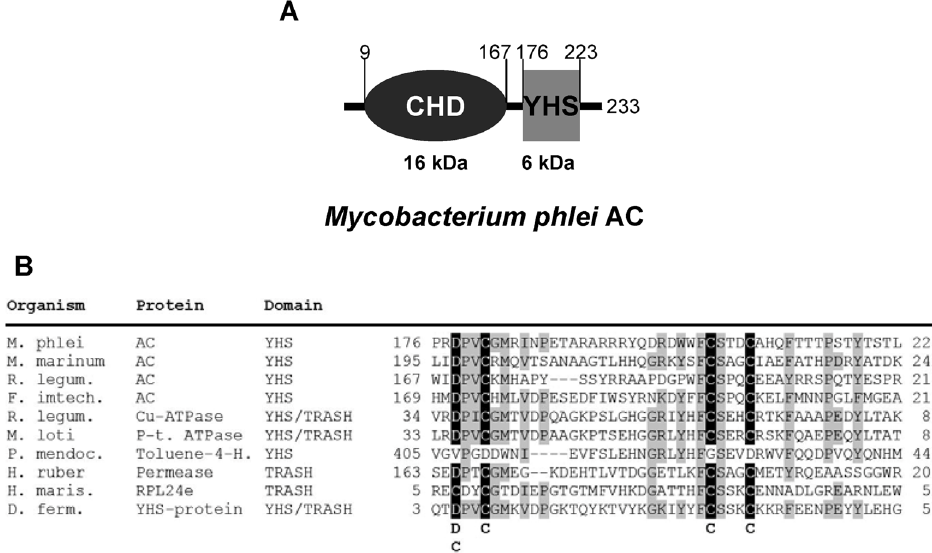
Fig 1. Sequence analysis of YHS-domains in ACs. (A) Modular organisation of ACs containing YHS- domains. Amino acid numbering refers to the AC from M . phlei . (B) Alignment of YHS-, YHS/TRASH- and TRASH-domains from various bacterial proteins. The four conserved residues implicated in transition-metal binding are shaded black. Other conserved residues are shaded grey. M . phlei AC, GenBank EID14989.1; Mycobacterium marinum AC, GenBank ACC39874.1; Rhizobium leguminosarum AC, GenBank KEC71354.1; Fulvivirga imtechensis AC, GenBank ELR73472.1; Rhizobium leguminosarum Cu-ATPase, GenBank AAD26860.1; Mesorhizobium loti P-type ATPase, GenBank BAB51797.1; Pseudomonas mendocina toluene-4-hydroxylase, GenBank AAA25999.1; Halovivax ruber permease, GenBank AGB15007.1; Haloarcula marismortui ribosomal protein L24e, GenBank AAV45180.1; Desulfurococcus fermentans YHS-protein, GenBank AFL66382.1.